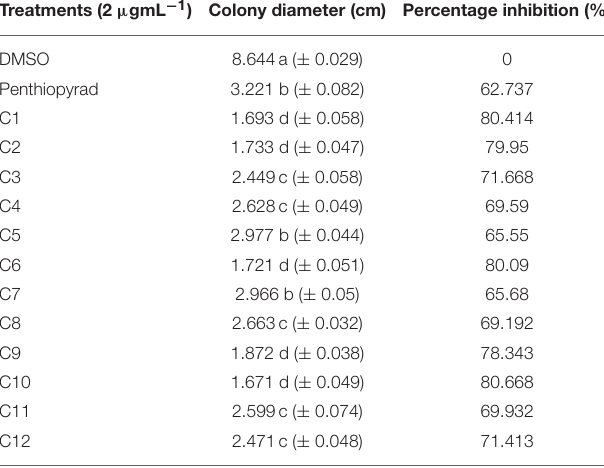
TABLE 2 | Comparison of disease control efficacy of SDHIs on detached leaves of Potato. Compounds